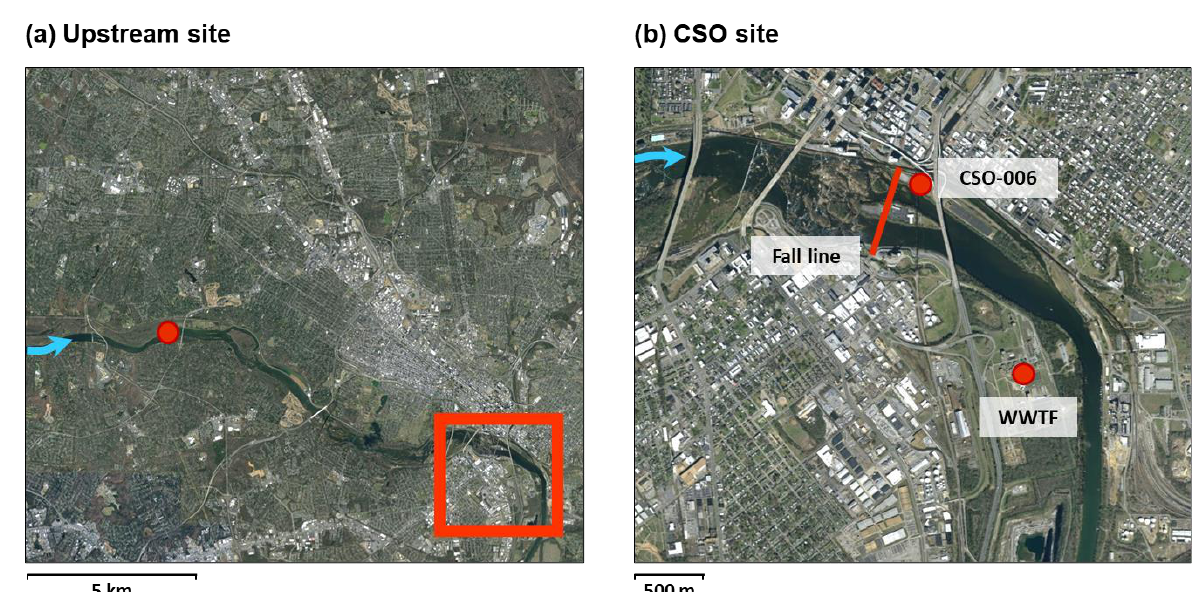
Figure 1. ( a ) Map of study area showing the direction of water flow (blue arrows) and the location of the upstream sampling site (red circle). The red inset box is expanded in panel ( b ) to show the sampling site at the CSO discharge point, the location of the city ′ s wastewater treatment facility (WWTF), and the approximate fall line of the James River.